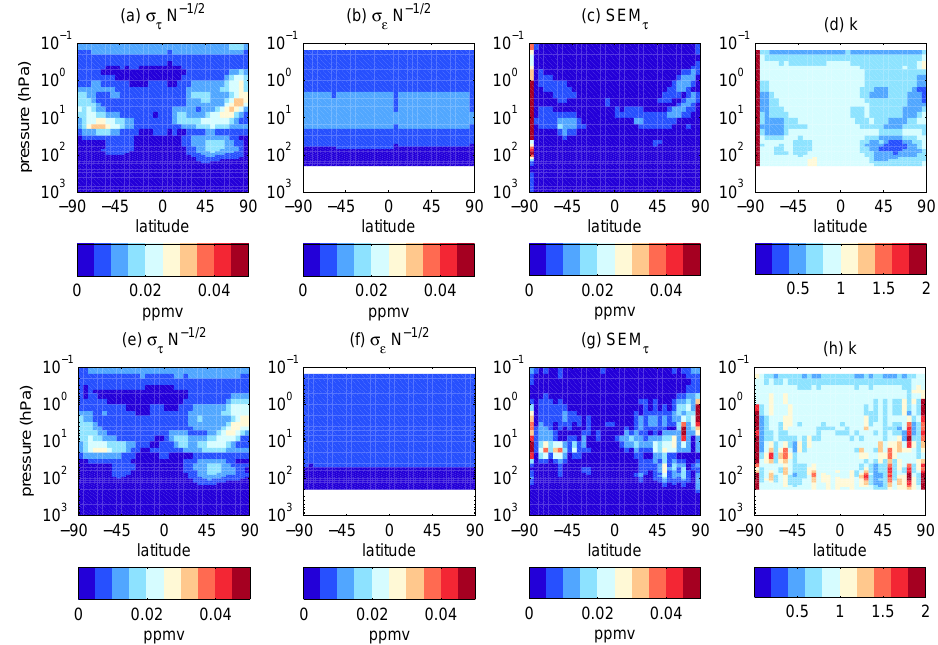
√ N , the single-sample estimate of the natural variability component of the Fig. 6. Pressure latitude sections of zonal mean values of σ τ / √ N , the random measurement error component of the SEM (second column); the empirically derived SEM τ (third SEM (first column); σ (cid:15) / column) and k as defined in text (fourth column) based on MIPAS-HR (top) and MIPAS-LR (bottom) sampling of CMAM March O 3